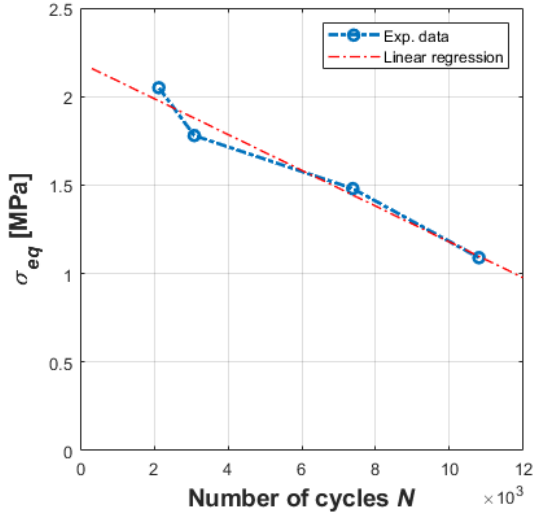
1 and the actuator deformation λ .